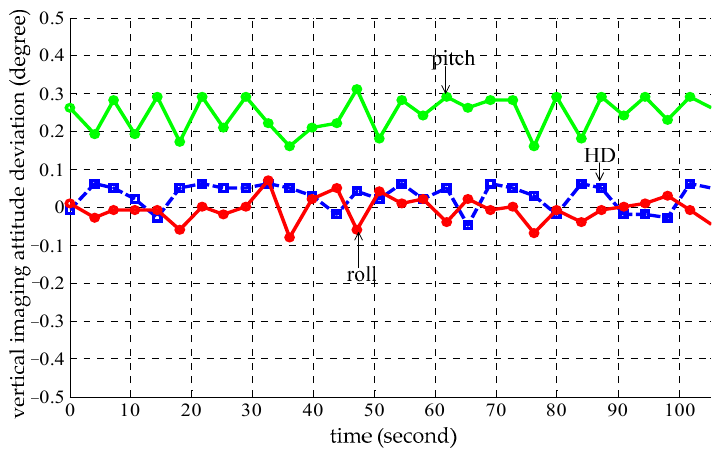
Figure 15. Image attitude deviation in the vertical imaging mode over time.